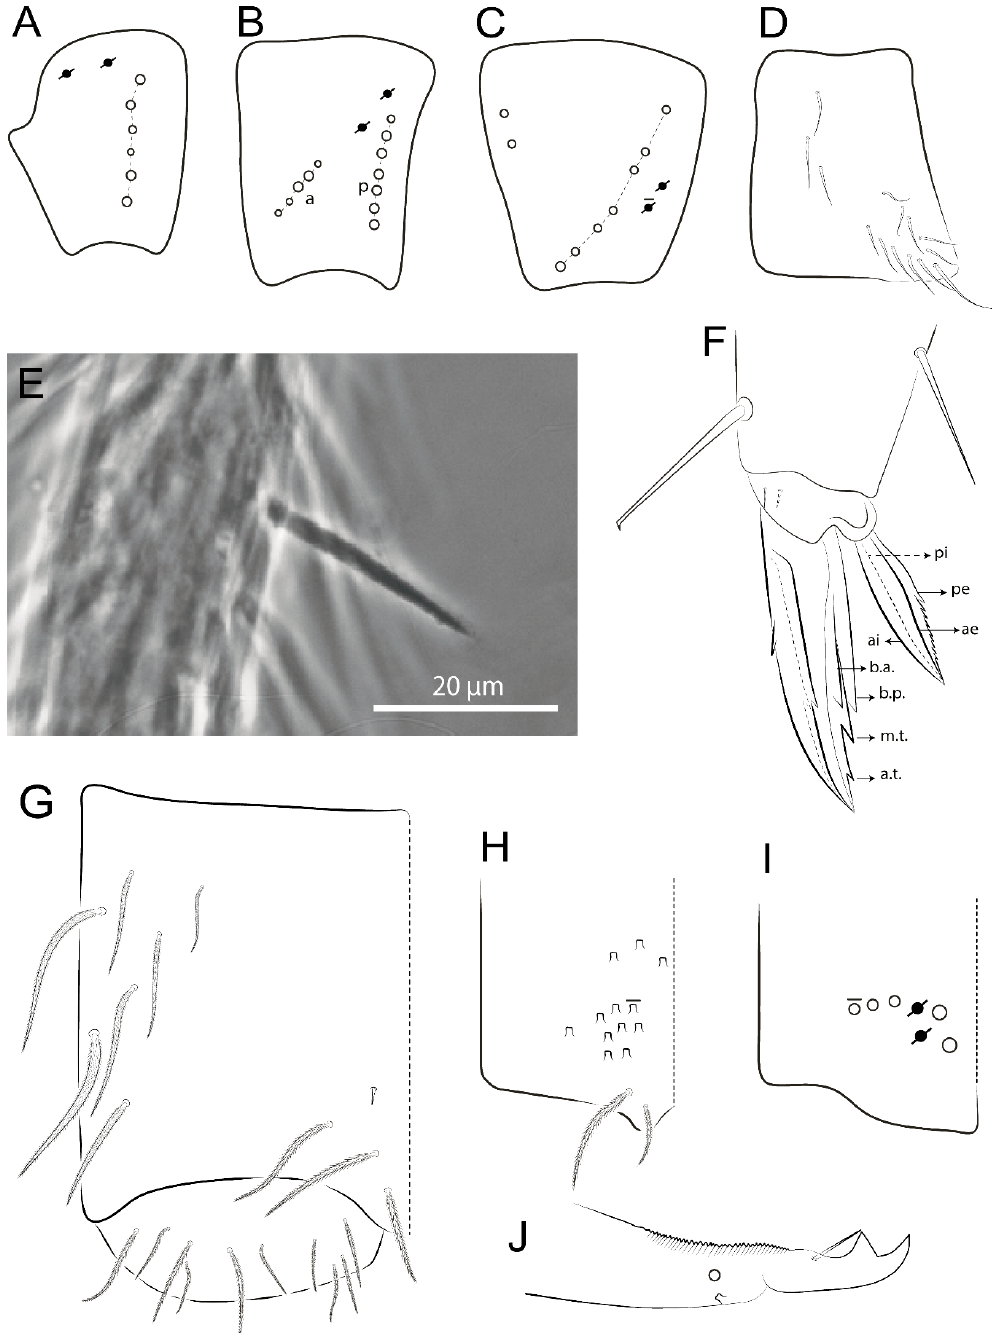
Figure 45. Pseudosinella cearensis sp. nov. ( A–C ) subcoxa I–III, respectively; ( D ) trochanteral organ; ( E ) modified chaeta of tibiotarsus; ( F ) distal tibiotarsus and empodial complex III (anterior view); ( G ) collophore (lateral view); ( H ) distal part of manubrium (ventral view); ( I ) manubrial plate (dorsal view); ( J ) distal dens and mucro (outer view).